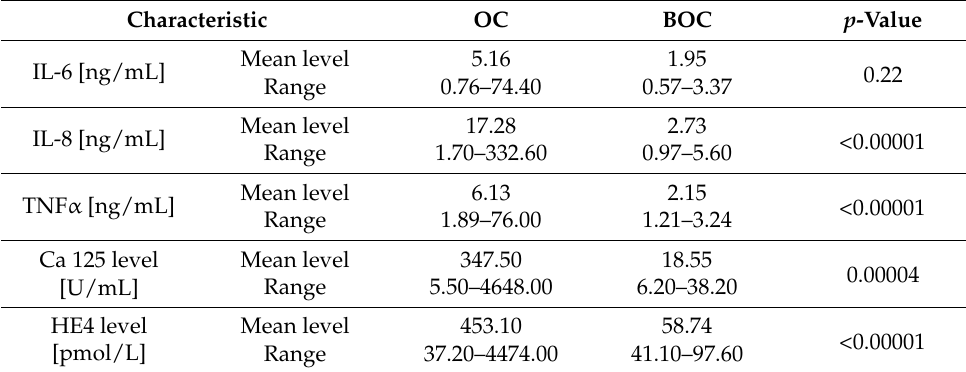
Table 3. Mean serum levels and ranges of IL-6, IL-8, TNF- α , Ca 125, and HE4 in Ovarian Carcinoma and Benign Ovarian Cystic Lesions